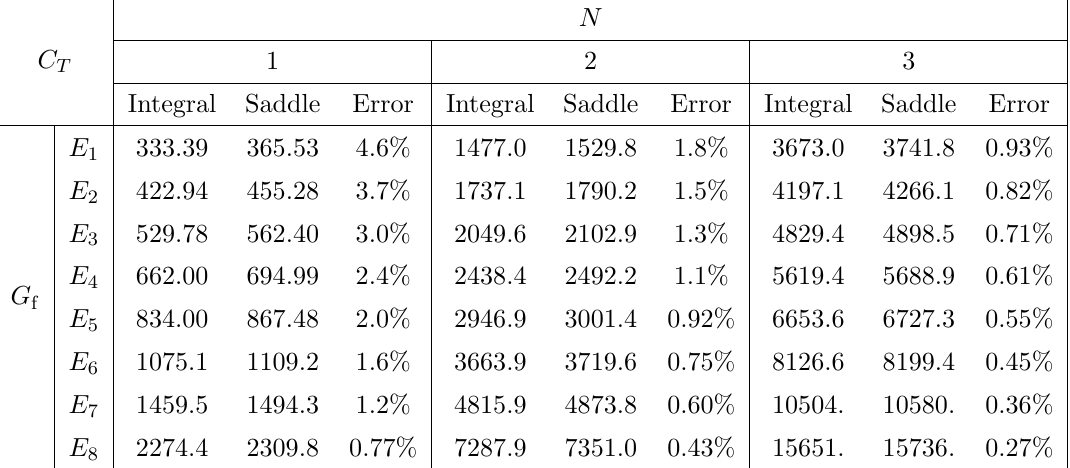
Table 3 . The perturbative values of the conformal central charge C Seiberg theories, computed by numerical integration and by the saddle point approximation.